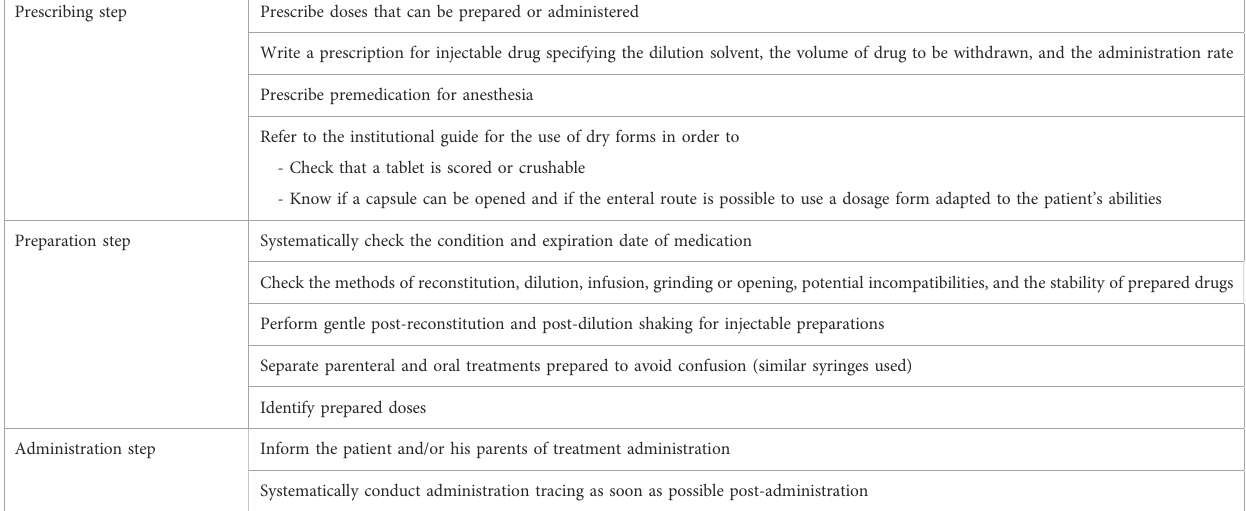
TABLE 4 Areas of improvement proposed in the audit